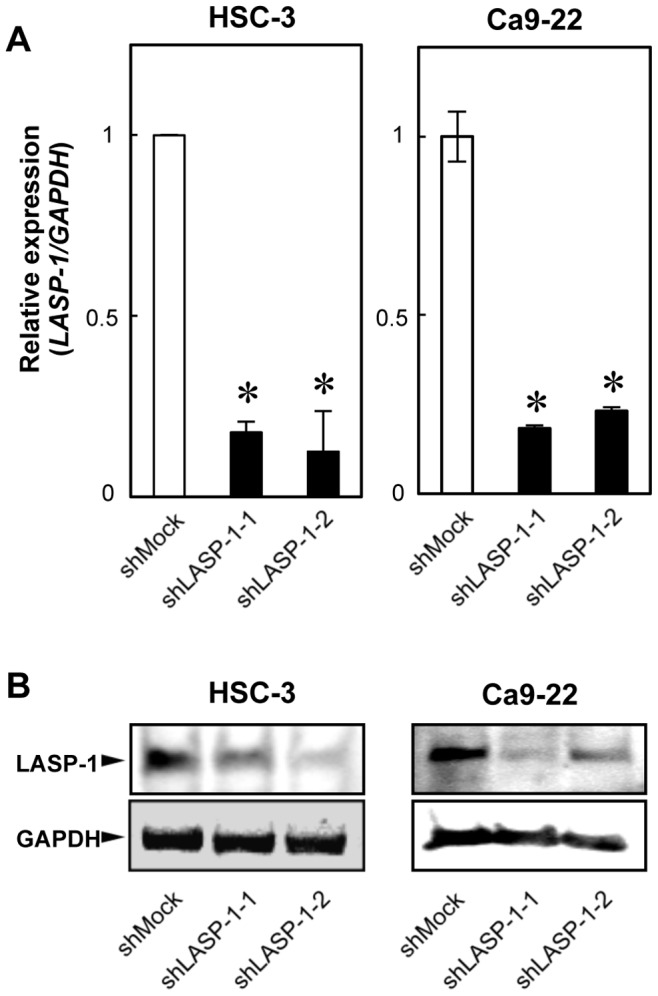
Expression of LASP-1 in shLASP-1-transfected cells.(A) Expression of LASP-1 mRNA in shMock- and shLASP-1-transfected cells (HSC-3- and Ca9-22-derived transfectants; 2 clones each). The LASP-1 mRNA expression in the shLASP-1 is significantly (*P<0.025; Mann-Whitney U test with Bonferroni correction) lower than that in the shMock-transfected cells. (B) Immunoblotting analysis of LASP-1 protein in the shMock- and shLASP-1-transfected cells (HSC-3- and Ca9-22-derived transfectants; 2 clones each). The LASP-1 protein in the shLASP-1 transfected cells is depleted markedly compared with the shMock-transfected cells.